Question: Which visualization type does this figure use?
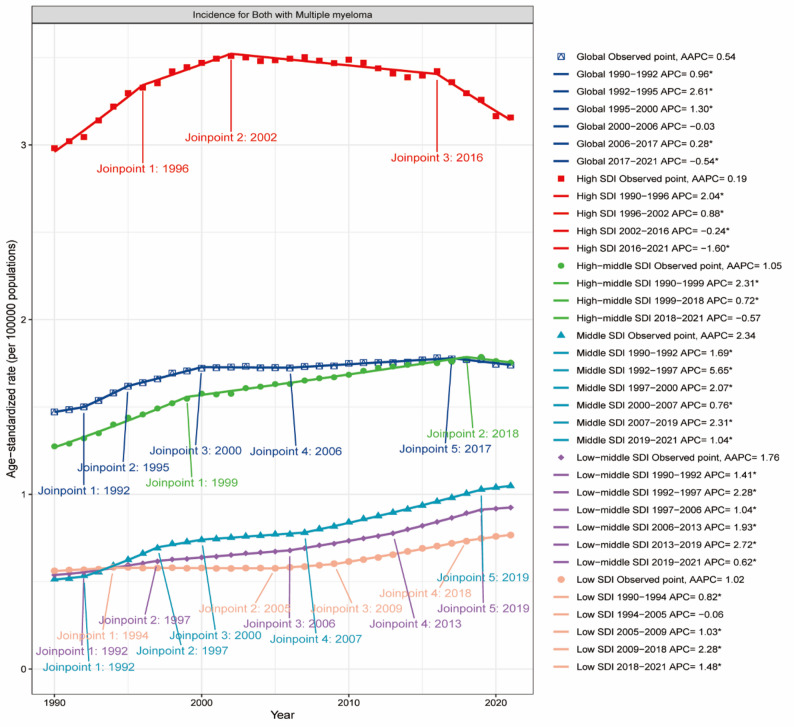
Answer: line